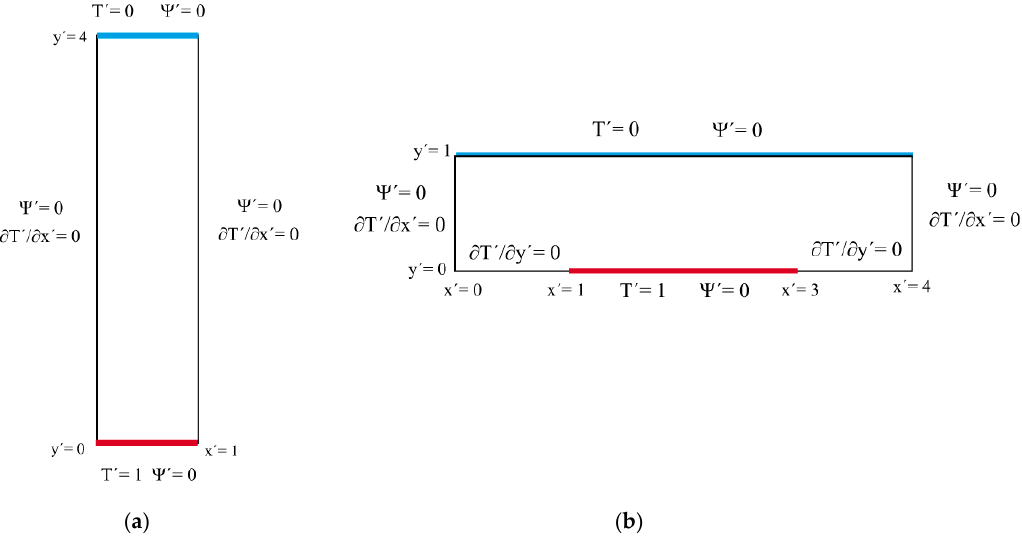
Figure 1. Physical scheme and geometry: ( a ) slender vertical box; and ( b ) Elder problem.